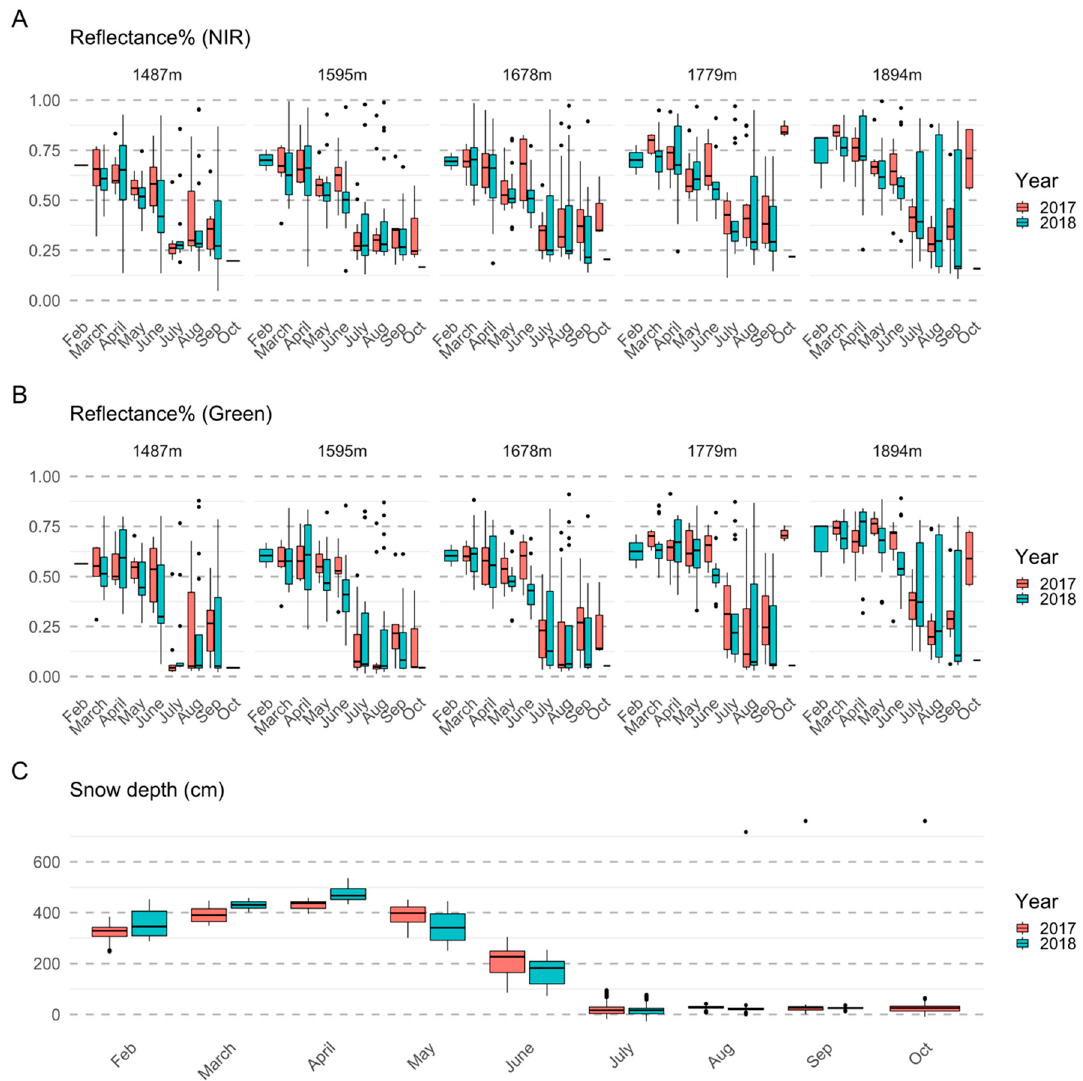
Figure A3. Combined Sentinel and Landsat reflectance comparison of NIR and green band showing snowmelt followed by green-up and flowering. ( A ) NIR reflectance is higher in snow months than in vegetative and flowering months, signified by positive correlation of reflectance’s with snow-depth; however, note the upward trend of NIR in late September and October, signifying onset of snow or drying vegetation. ( B ) Green reflectance shows lower reflectance (i.e., higher absorption) after the snow-melt, signifying green-up. ( C ) Snow-depth plot from the metrological records highlighting snow-free months after June.